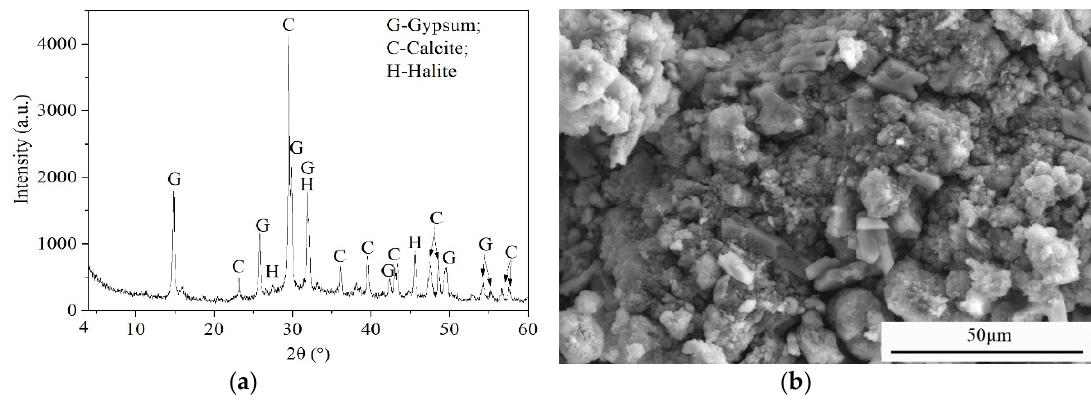
Figure 2. XRD pattern ( a ) and SEM image ( b ) of SR. Table 1. Chemical compositions of SR and GGBS used in this study (wt.%).